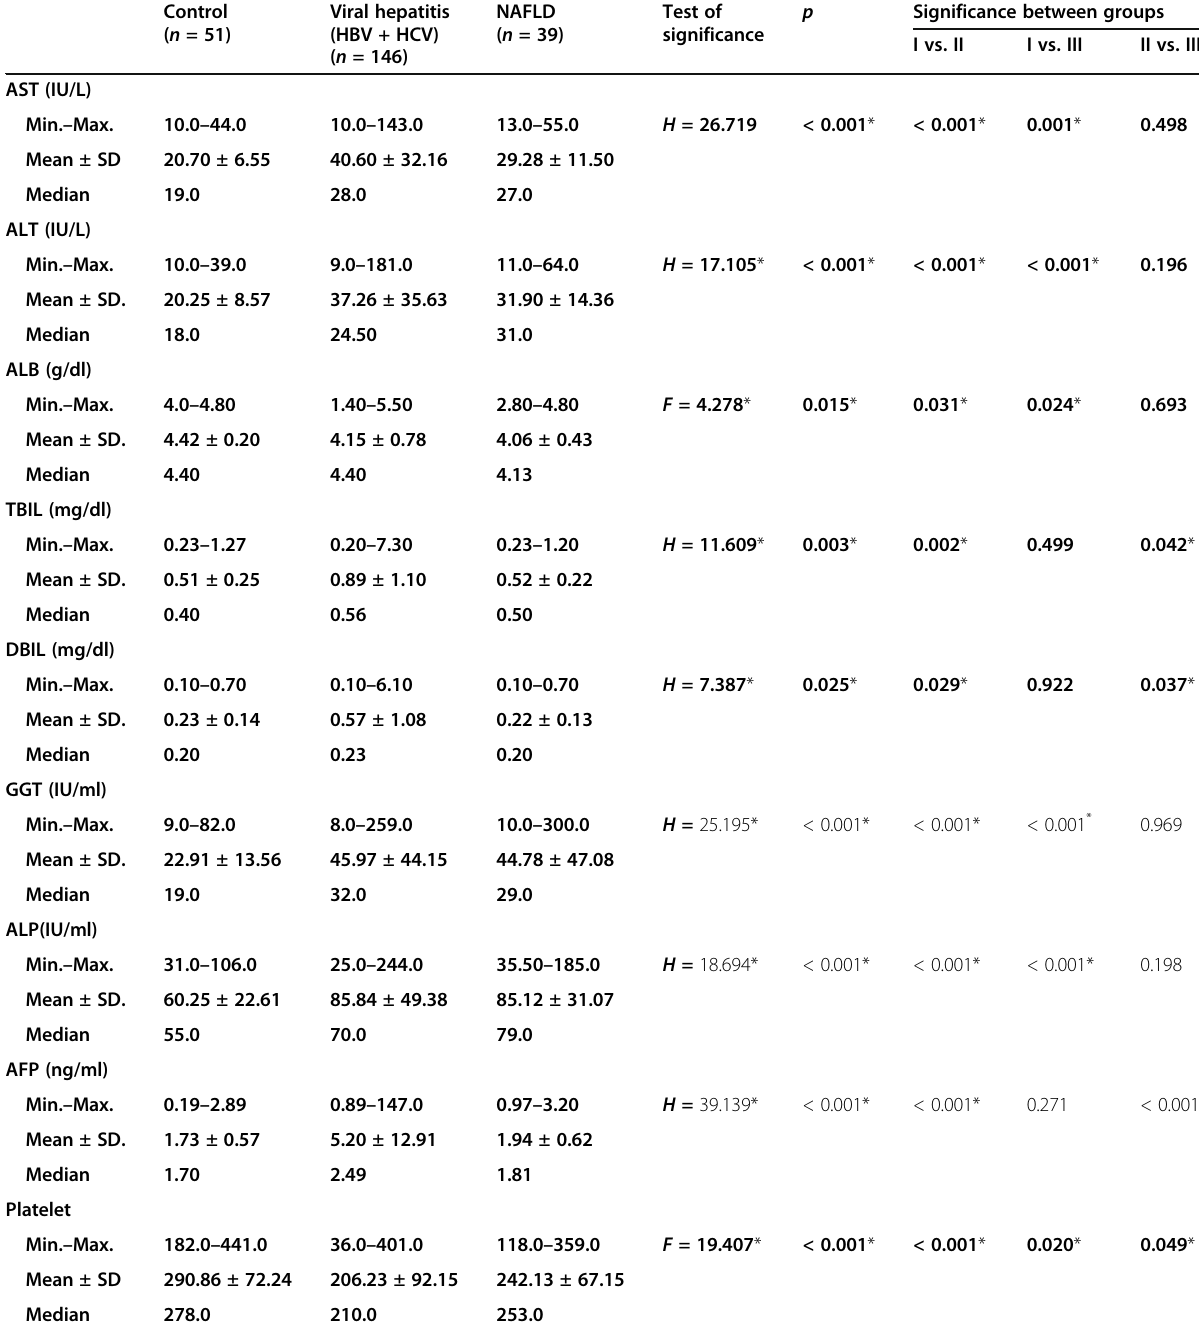
Table 1 Comparison between the studied groups regarding biochemical data Control Viral hepatitis ( n = 51) (HBV +